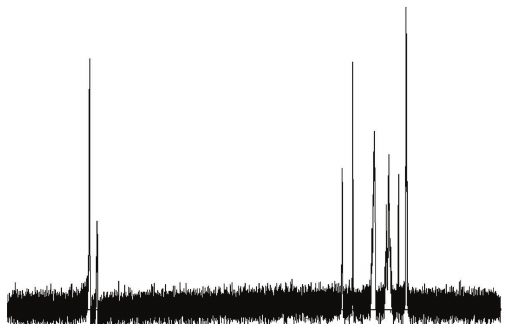
Figure 3: 13 C-NMR spectum of copolymer AM/AMPS 90 :10.